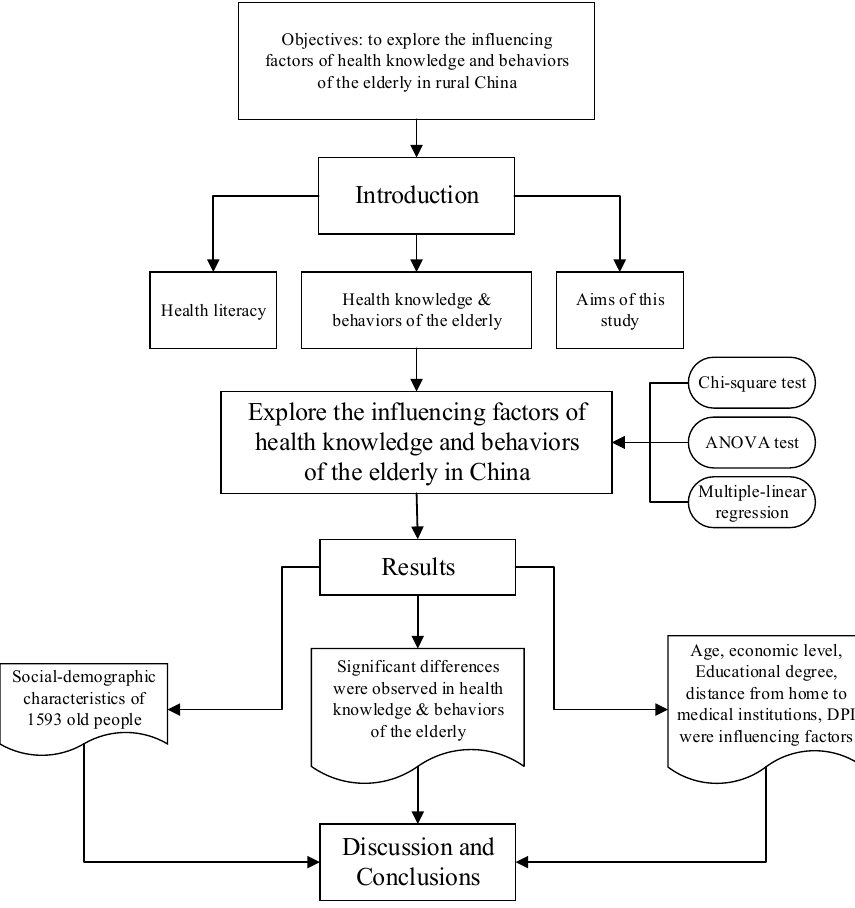
Figure 1. Framework of this research.